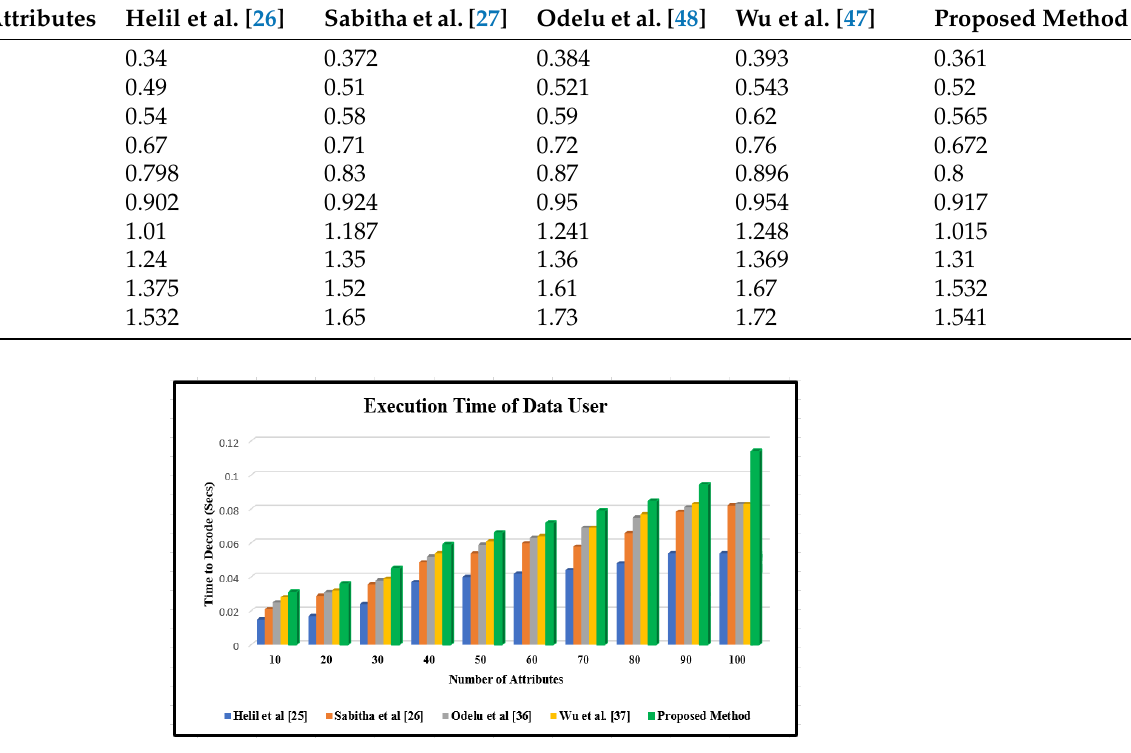
Figure 9. Decipher time in user part. Table 5. Execution time of the data